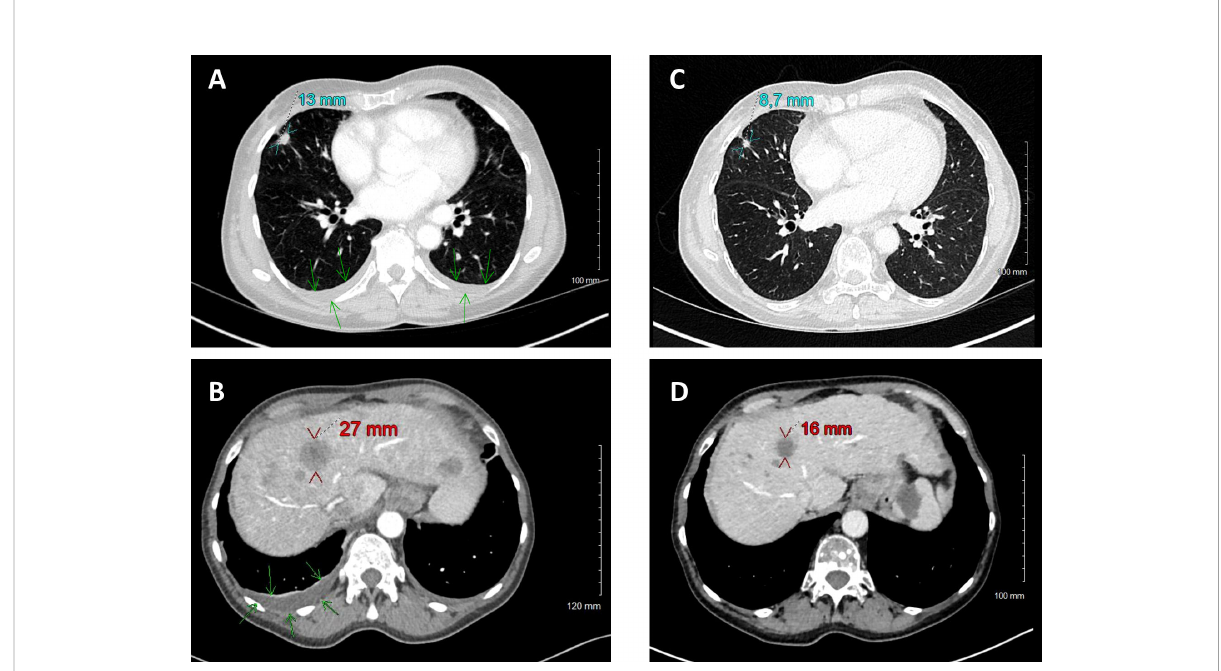
FIGURE 2 Comparison of CT scans before (June 7, A , B ) and with osimertinib treatment (August 29, C , D ). Size reduction of primary tumor (cyan) and target hepatic metastasis (red). Disparition of pleural effusion (green